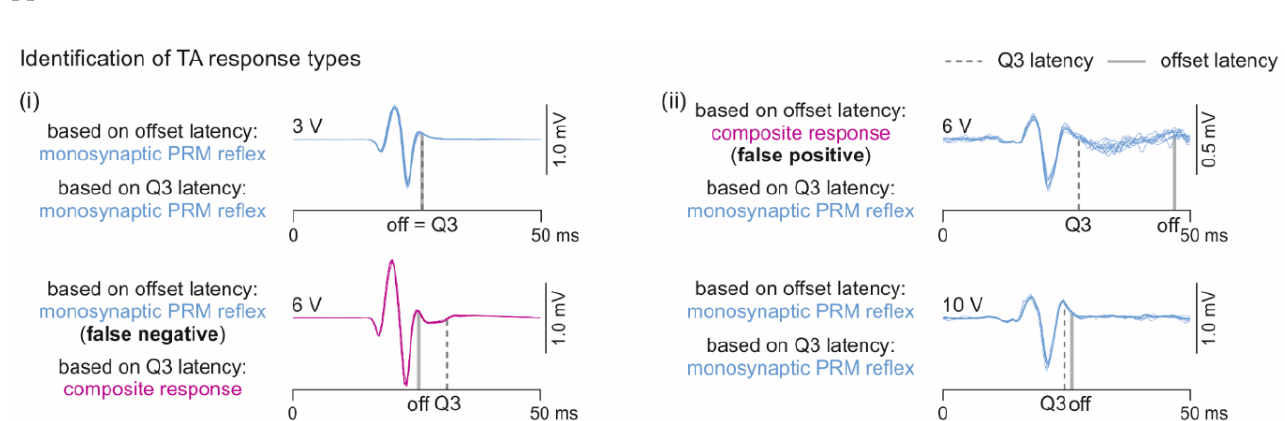
Figure A1. Identification of TA response types based on offset and Q3 latencies. ( i ) Response type classification based on the offset latency produced a false negative result for the responses evoked with EES at 6 V; subject 2, recording 1, electrode setup 0 − 3+. ( ii ) Response type classification based on the offset latency produced a false positive result for the responses evoked with EES at 6 V; subject 3, recording 1, 2 − 3+. In both examples, response type classification based on the Q3 latency produced correct results.